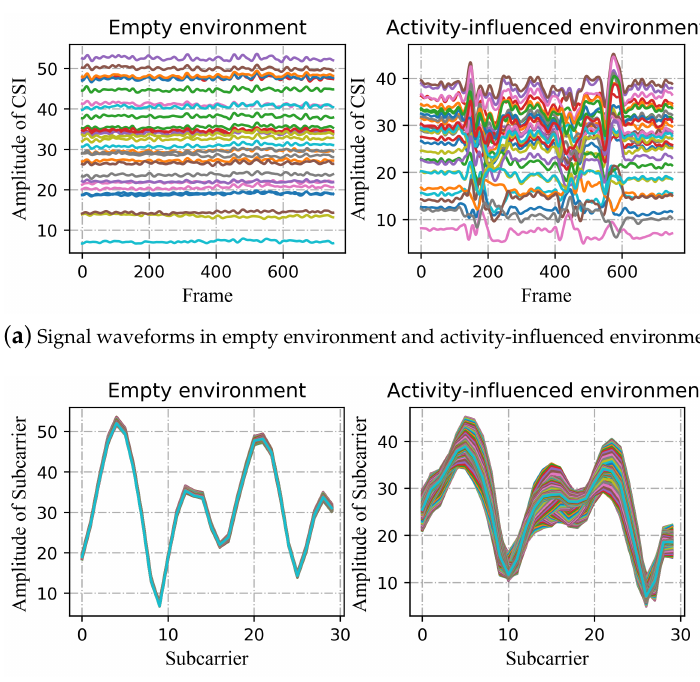
Figure 7. Two-dimensional map of signal in empty environment and activity-influenced environment. ( a ) The horizontal axis represents the frame/packet, the ordinate indicates the amplitude of CSI. Each curve in the figure represents one of the 30 subcarriers; ( b ) the horizontal axis represents the subcarrier index, the ordinate indicates the amplitude of the subcarriers. Each curve in the figure represents one of the 750 curves, which illustrate the amplitude change of each subcarrier within 3.5 s (The sampling rate is 200